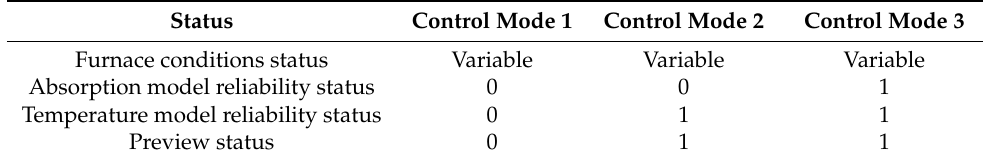
Table 7. Control modes activation matrix.